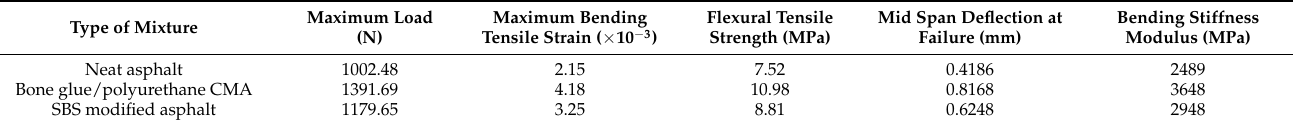
Table 11. Low-temperature stability test